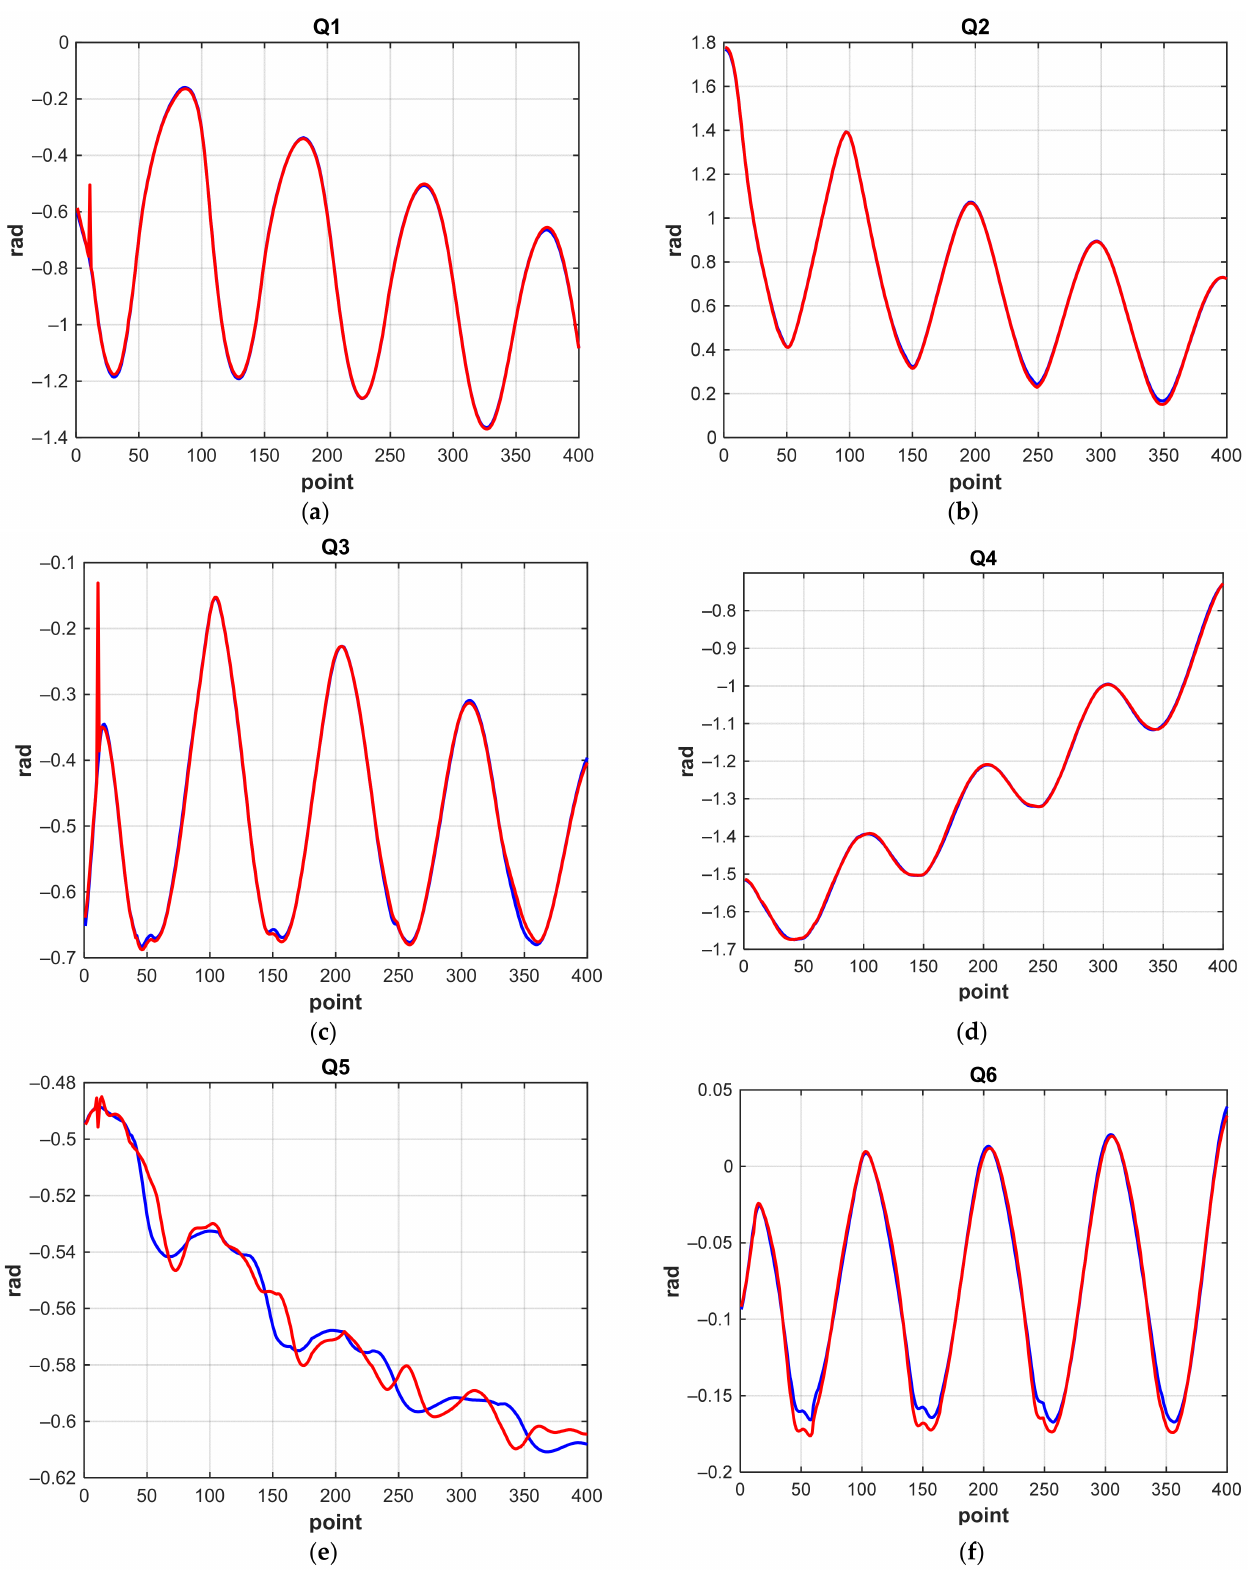
Figure 22. Graphs of changes in generalized coordinates when the manipulator moves along a 3D spiral (the correctional NN): ( a ) q1; ( b ) q2; ( c ) q3; ( d ) q4; ( e ) q5; ( f )